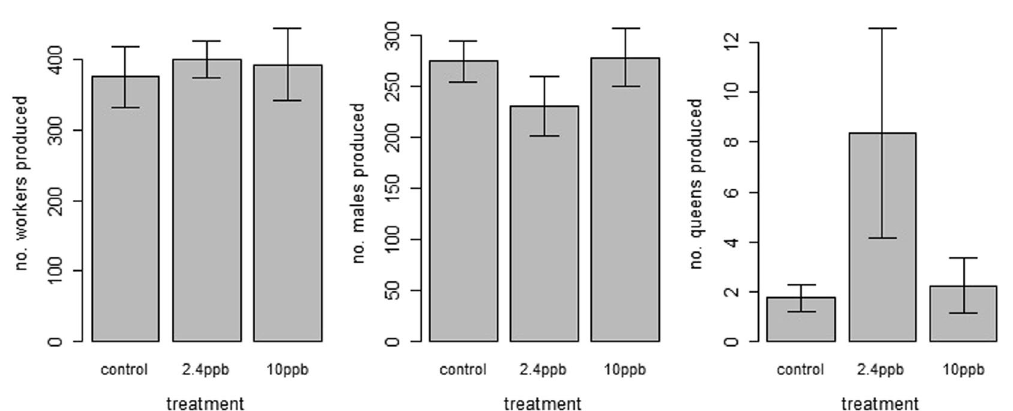
Figure 2. The mean number of workers, males and queens produced per Bombus terrestris colony, with colonies exposed to control, 2.4ppb thiamethoxam and 10ppb thiamethoxam. N = eight colonies per treatment (24 colonies in total), and error bars show standard error. No significant difference was found between any of the treatments in all three